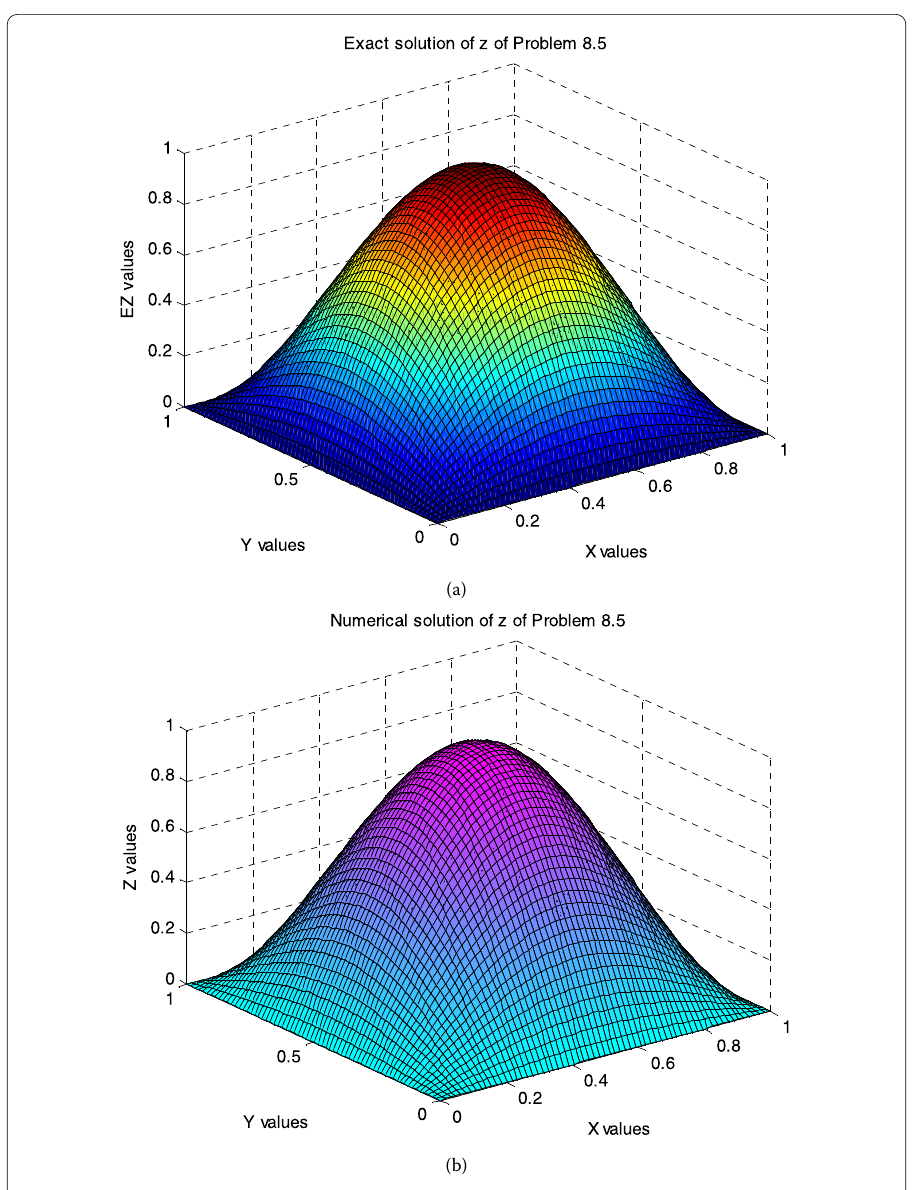
Figure 6 ( a ) Exact solution of Problem 8.5 for z ( x , y ) for h = 1/64 and Re = 10. ( b ) Numerical solution of Problem 8.5 for z ( x , y ) for h = 1/64 and Re = 10. ( c ) Exact solution of Problem 8.5 for v ( x , y ) for h = 1/64 and Re = 10. ( d ) Numerical solution of Problem 8.5 for v ( x , y ) for h = 1/64 and Re = 10